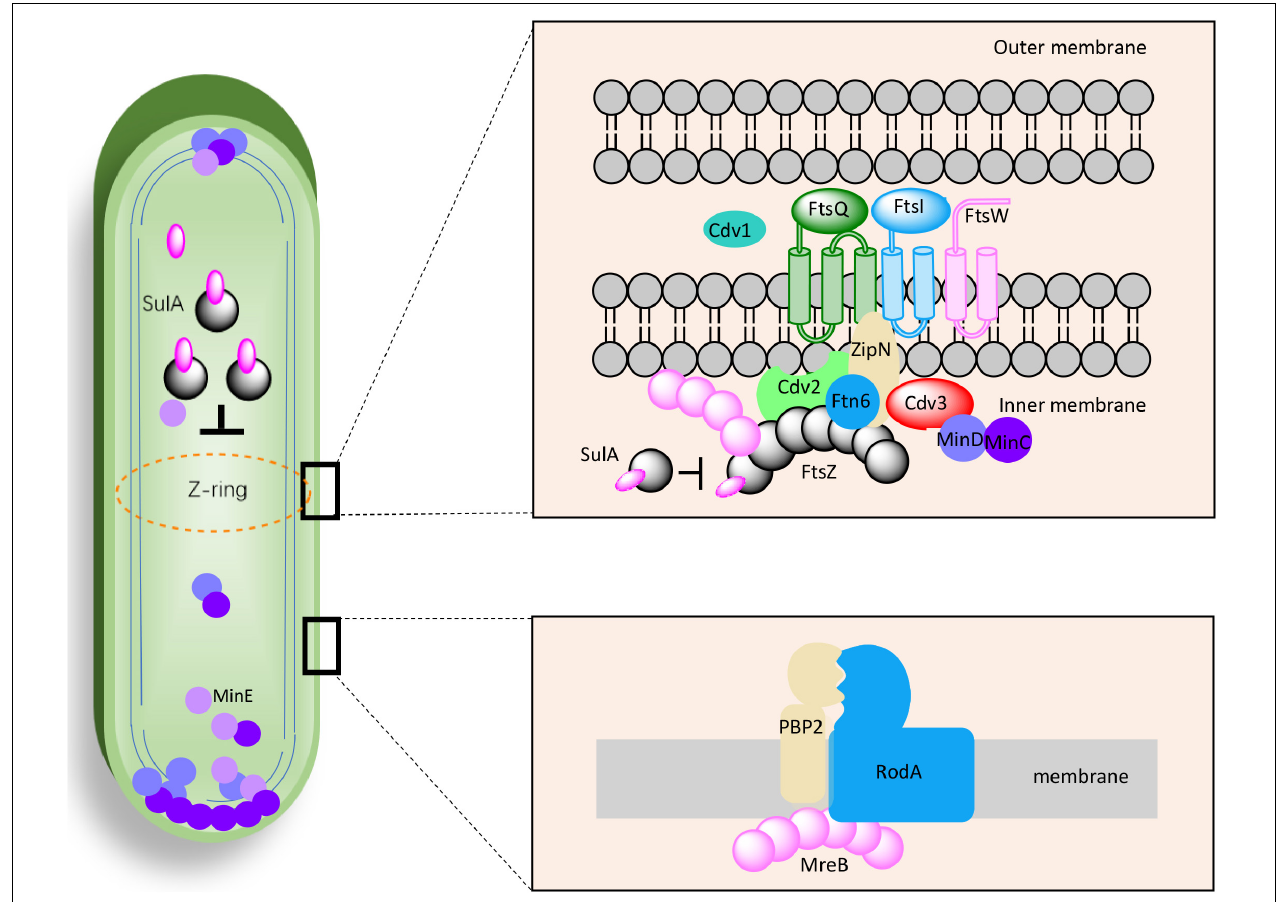
FIGURE 1 | Proposed working model for the factors potentially participating in cell morphogenesis of PCC7942. The interactions, locations, and components were selected and illustrated referencing previous discoveries in Escherichia coli , Bacillus subtilis , and Synechocystis sp.